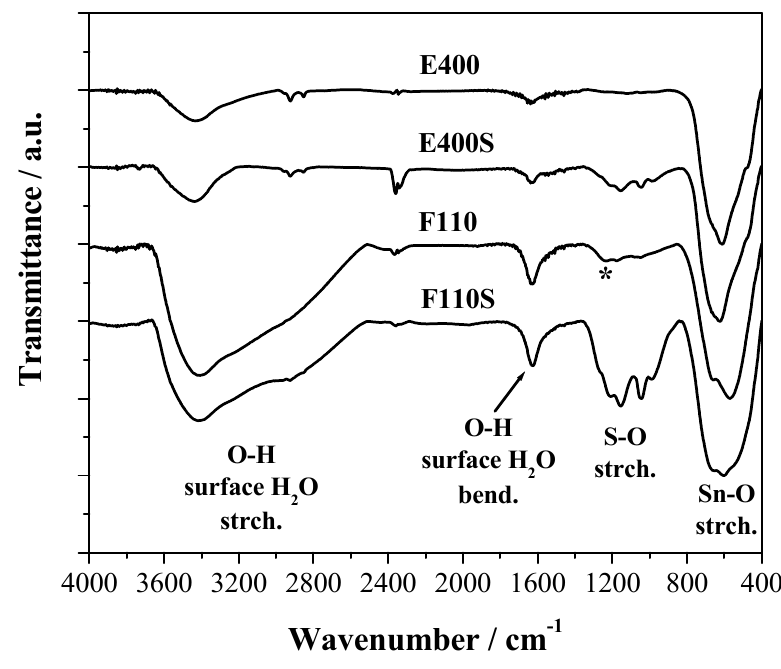
Figure 4. Fourier Transform Infrared (FTIR) spectra of the bare and sulphated oxides. The (*) symbol corresponds to the Sn–OH bending